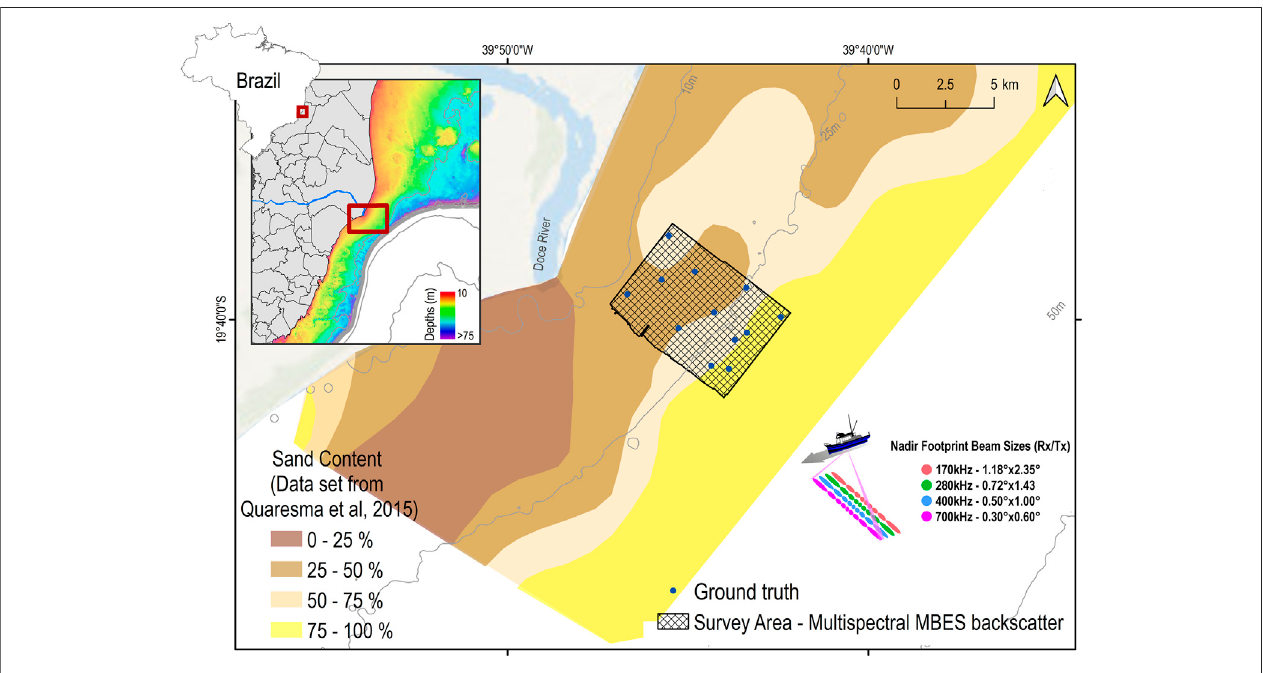
FIGURE 1 | Map of the study area (bathymetry adapted from Bastos et al., 2015), with sand content estimated by Quaresma et al. (2015). On the right-hand side, an illustration of multispectral MBES acquisition indicates frequency changes between sequential pings, and the nadir beam footprint sizes for each frequency.